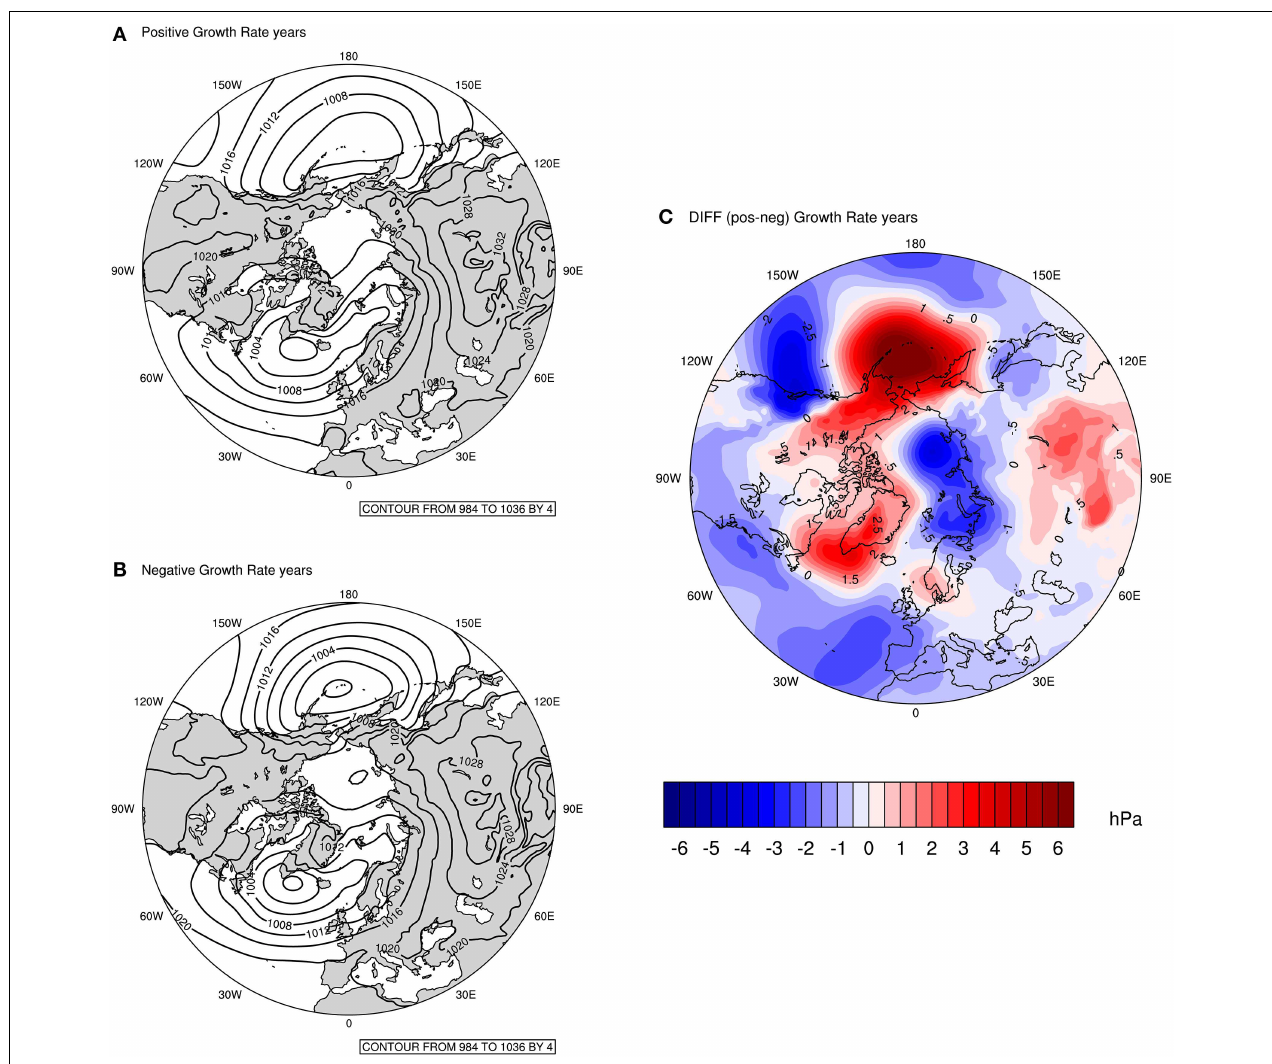
FIGURE 4 | MSLP Composite for: (A) Five years with the highest positive guillemot population growth rates (top left); (B) Five years with the highest negative population growth rates (bottom left); (C) Difference between 5 years with highest positive and 5 years with highest negative population growth rates. Units: